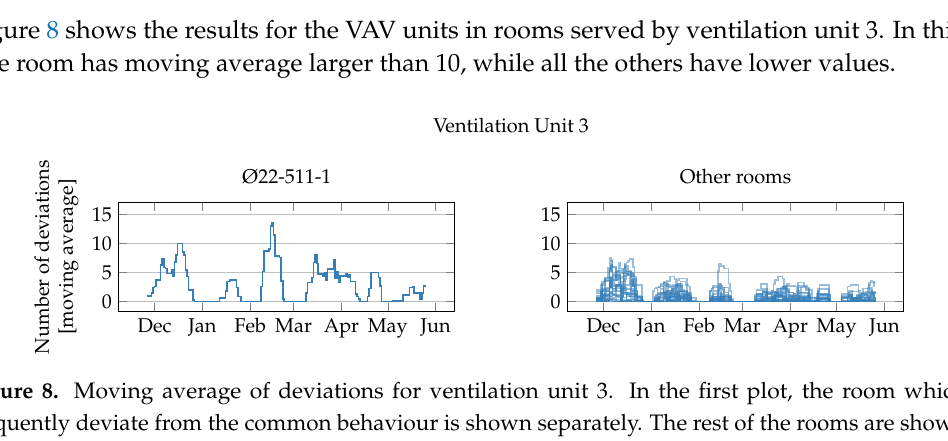
Figure 7. Moving average of deviations for ventilation unit 2. In the first three plots, the rooms which frequently deviate from the common behaviour are shown separately. The rest of the rooms are shown together in the last plot.